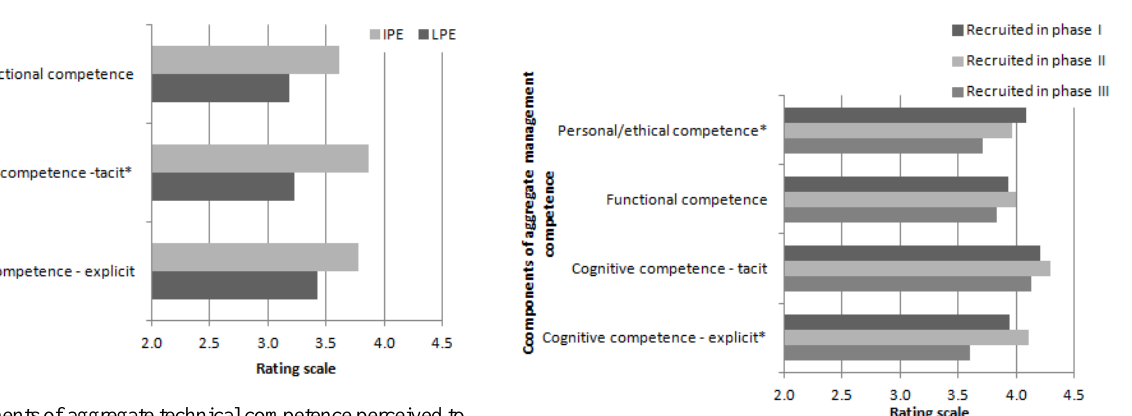
Fig. 6. Components of aggregate technical competence perceived to be acquired during local post-graduate education and international post-graduate education; rating scale from 1 to 5, where 1=not at all, 3=to some extent, and 5=extensively.